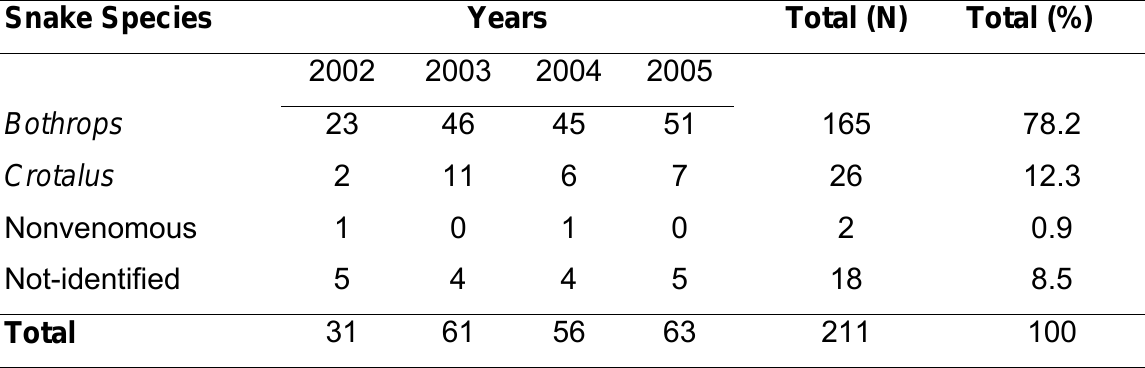
Table 1. Annual distribution of snakebite accidents in the southwest of Goiás State, Brazil, between January 2002 and December